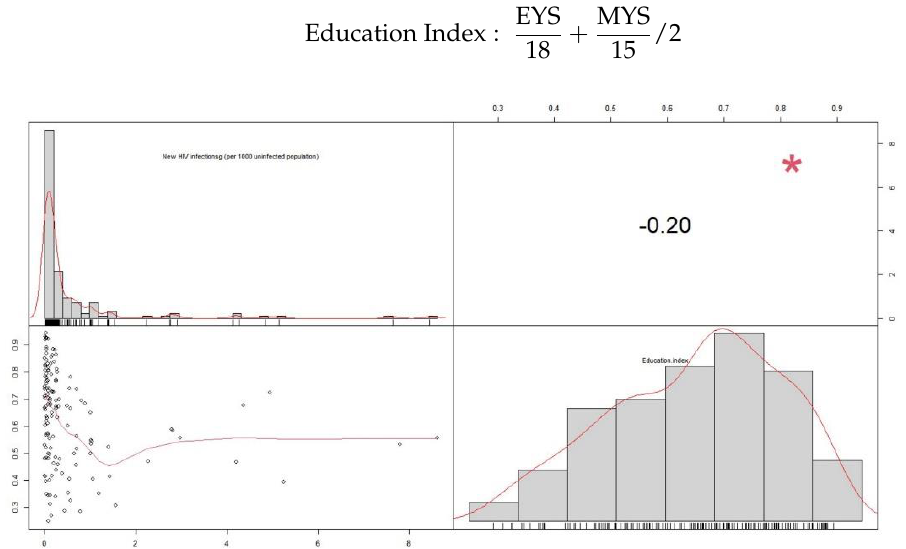
Figure 15. Education index correlation big data analysis according to STDs (HIV infection) rate.